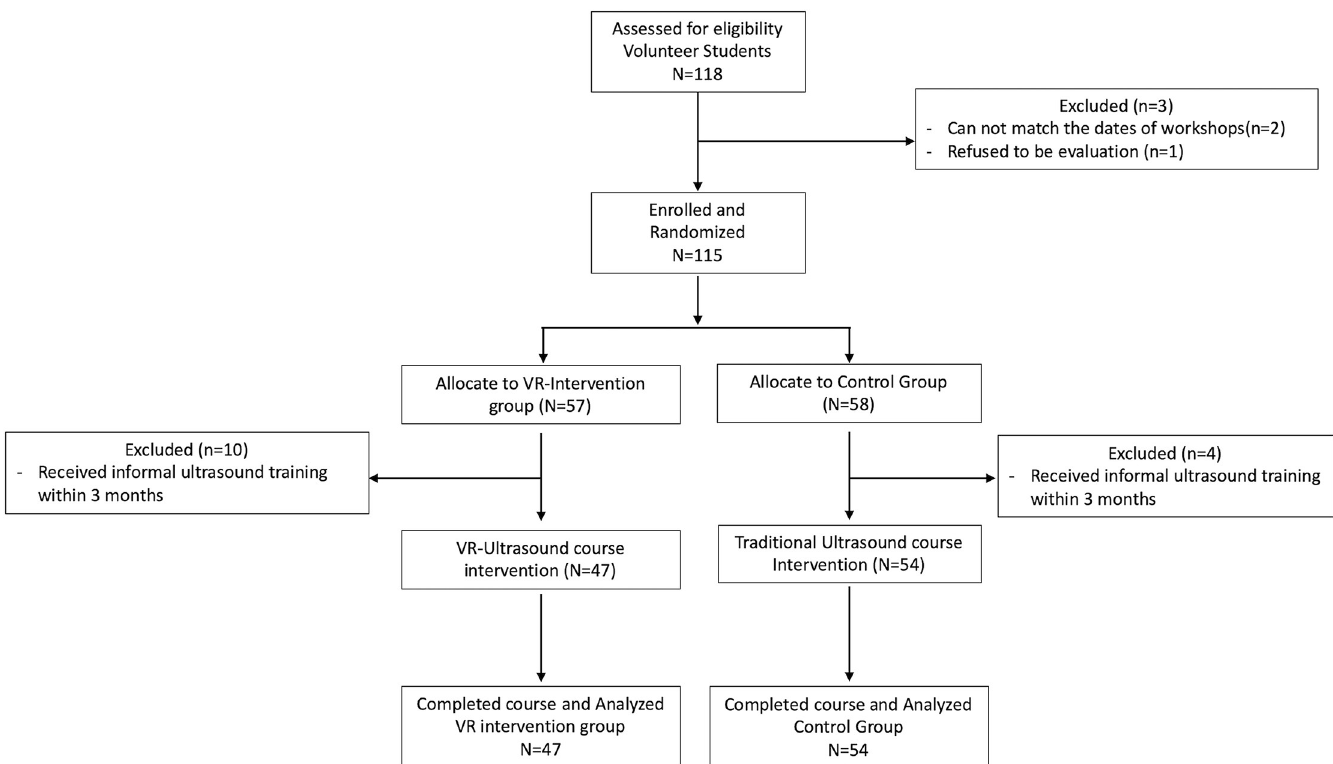
Fig 1. Randomization flow